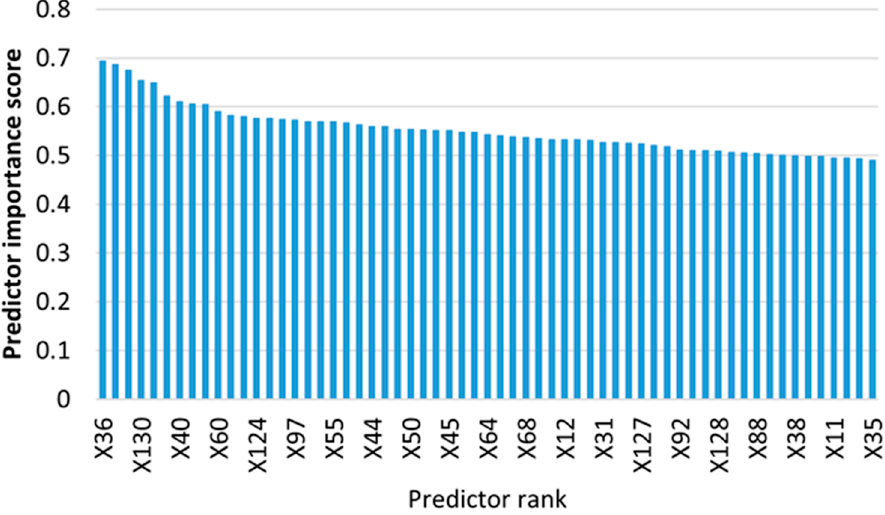
Figure 17. Optimal sensors ranking with the predictor importance score. X36 (vibration-2X in bearing #2) is selected to be the most sensitive sensor with a predictor importance score of 0.698, followed by turbine bearing metal temperature #1. Figure 18 lists the 61 optimal sensors selected by the mRMR algorithm.